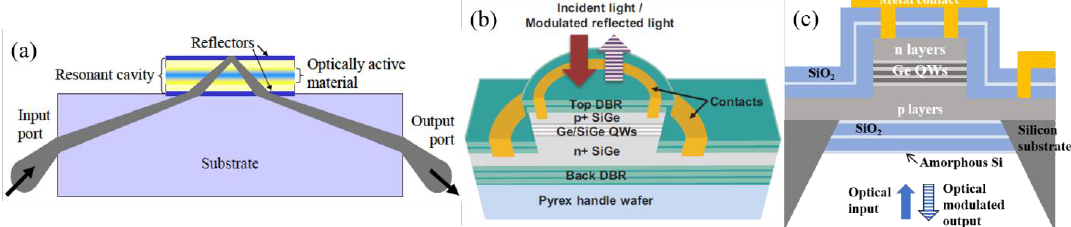
Figure 1. ( a ) Schematic view of side-entry Ge/SiGe MQW optical modulator [36]. ( b , c ) Schematic views of vertical-incidence electro-absorption modulators [39,40]. (Reproduced with permission from [36] and [39] © 2007 and 2012 the Optical Society, and [40] © 2013